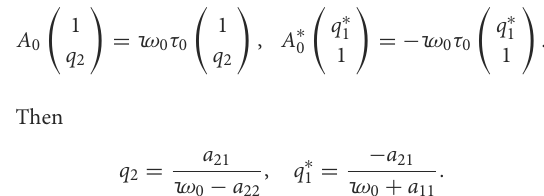
FIGURE2 The range of Turing instability in the general diffusion system about D u and D v